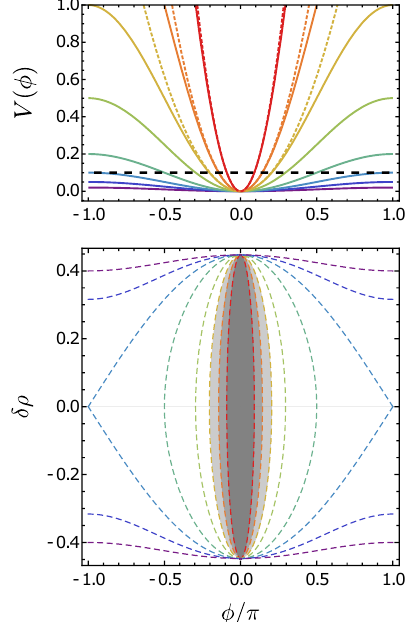
Figure 7: Semi-classical explanation of the dominance of density over phase fluc- tuations in the sine-Gordon model. Ignoring the spatial variation of the phase, the sine-Gordon model can be approximated as the quantum analogue of the classical pendulum [ 53 ] . Top: At a fixed temperature (corresponding to mean total energy denoted by the dashed black line), increasing J results in a steeper and narrower po- tential well that can be approximated by a parabola (dashed colored lines). Bottom: Seeing from a phase-space point of view, increasing J results in stronger ‘squeezing’ of the wave-function, illustrated through the elongation of the dashed line contours that represent the energy levels (or the shape of a phase space distribution of a clas- sical thermal ensemble). The values of J from purple to red are 0.01, 0.025, 0.05, 0.1, 0.25, 0.5, 1., 2.5 and the mean total energy level is E =